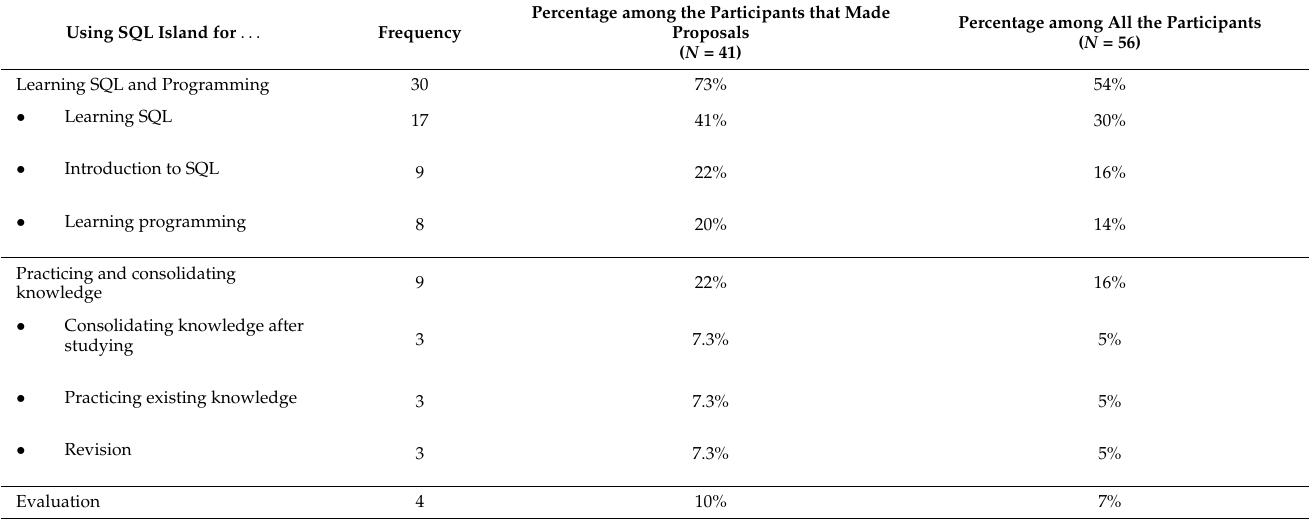
Table 5. Potential usages of SQL